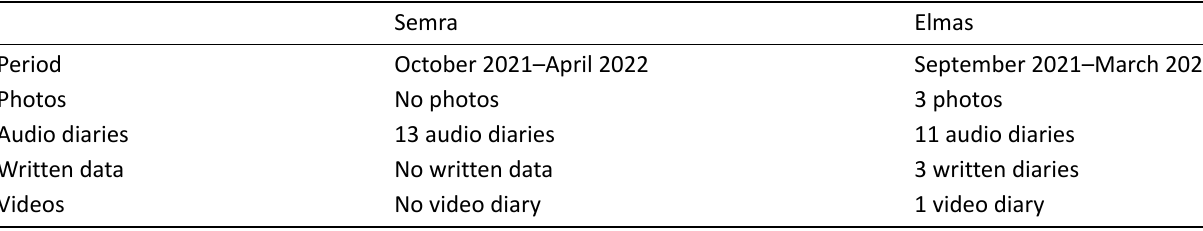
Table 1. Summary of the data